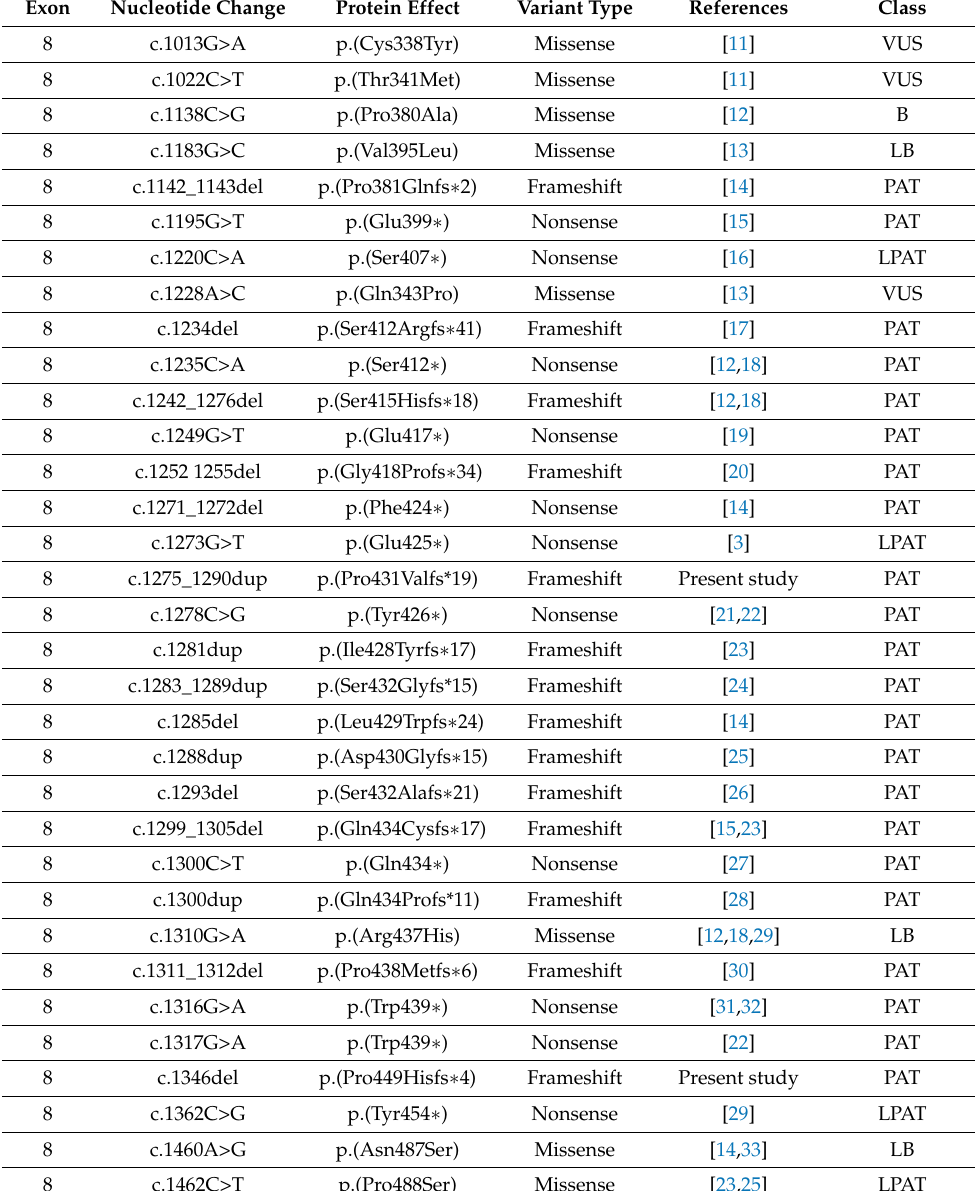
Table 1. PFCP-associated EPOR variants reported to